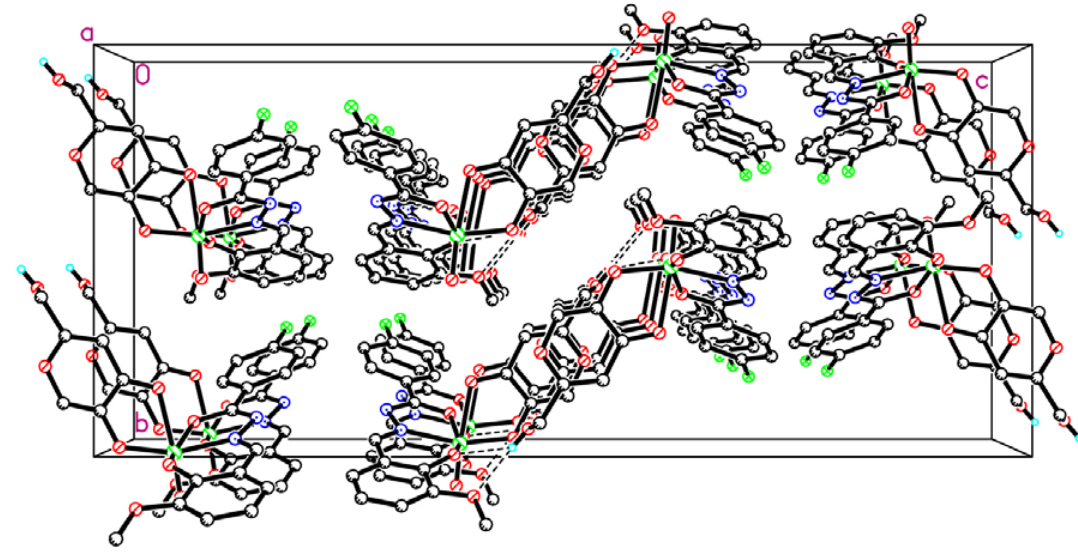
Figure 4. The crystal packing of the complex, viewed along the a axis. Hydrogen bonds are shown as dashed lines.